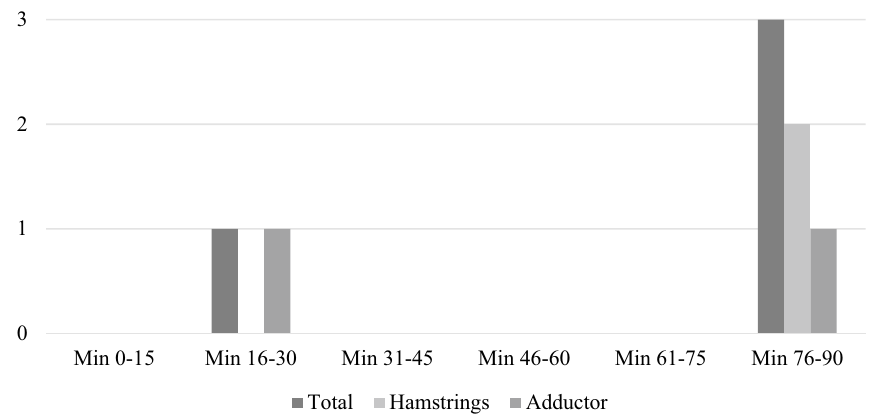
Figure 1. Distribution of muscular injuries during a match over an entire season.